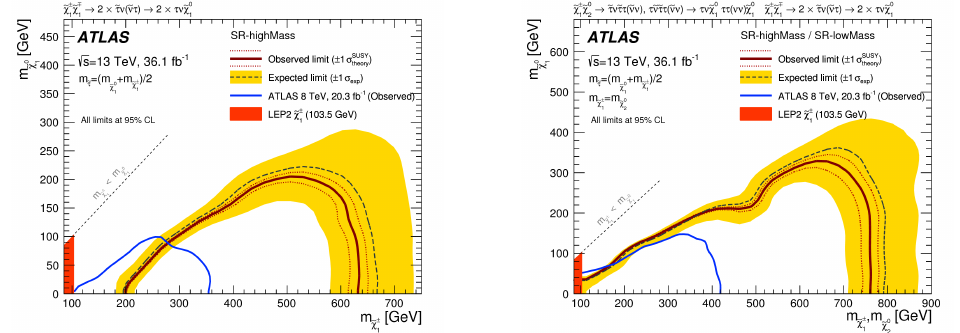
˜ χ − produc- 1 1 ˜ χ − ˜ χ 0 and ˜ χ ± (right) [ 16 ] . 2 1 1 1 and ˜ χ 0 . Charginos and next-tolightest 2 1 ( ν τ ) ˜ χ 0 −→ ˜ ττ −→ ττ ˜ χ 0 −→ ˜ ν ν −→ ν ν χ 0 , ˜ χ 0 , and ˜ χ 0 τ τ τ τ τ τ ˜ 1 2 1 2